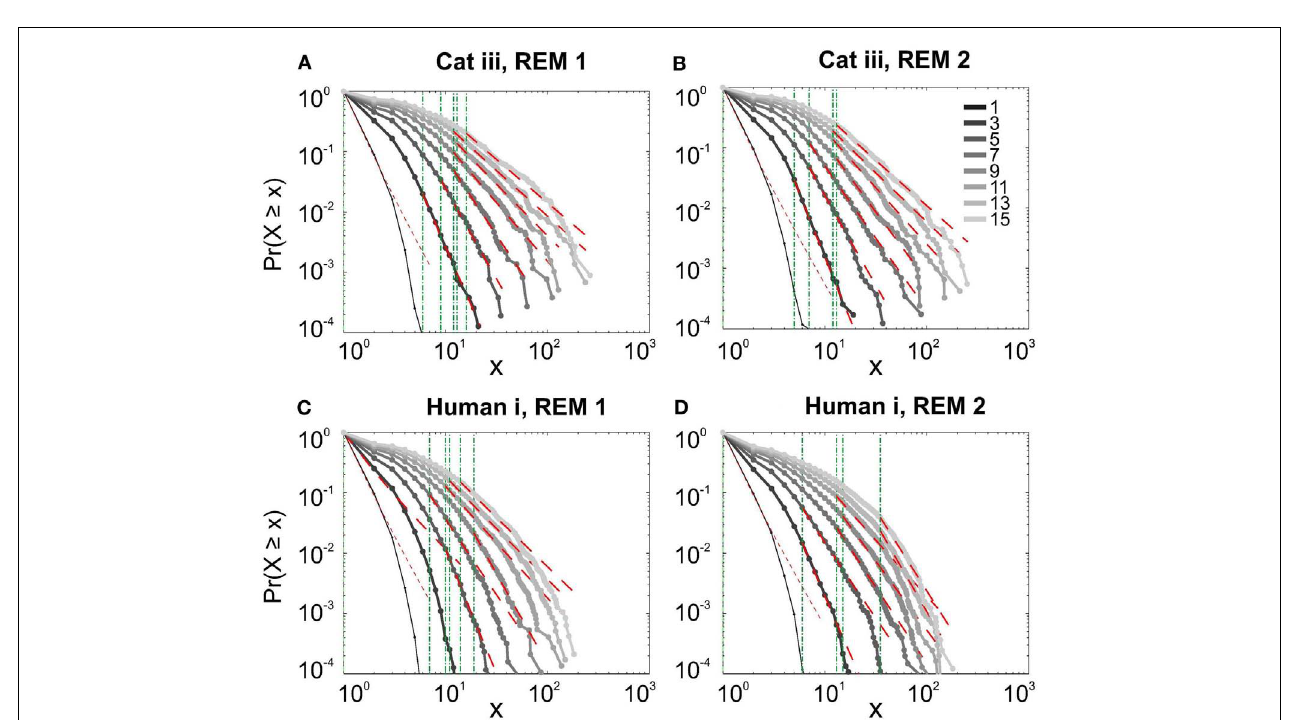
as shown in the legend. Similar to awake and SWS, the lack of criticality, variability through different coarse graining thresholds, and lower bounds is the universal finding. For the mean/STD exponent values, see Table 1 .